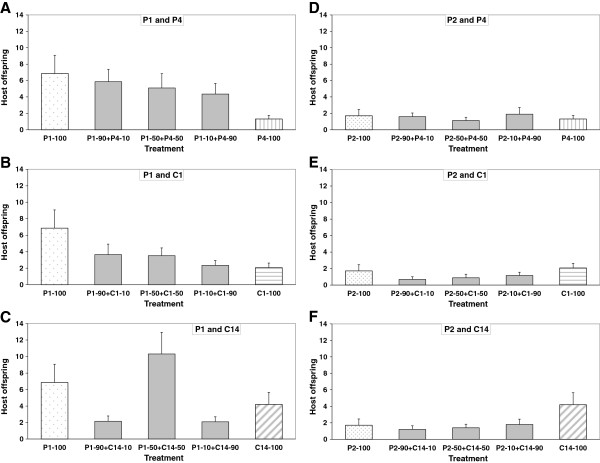
Lifetime number of host offspring produced (host fitness) in single and mixed infections. Lifetime number of host offspring produced (host fitness) in single and mixed infections by the parasite isolates/clones (A) P1 and P4 (B) P1 and C1 (C) P1 and C14 (D) P2 and P4 (E) P2 and C1, and (F) P2 and C14. Error bars are standard errors.